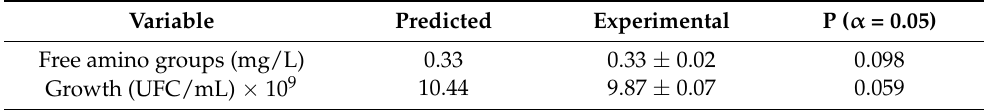
Table 3. Predicted and experimental values of the model.